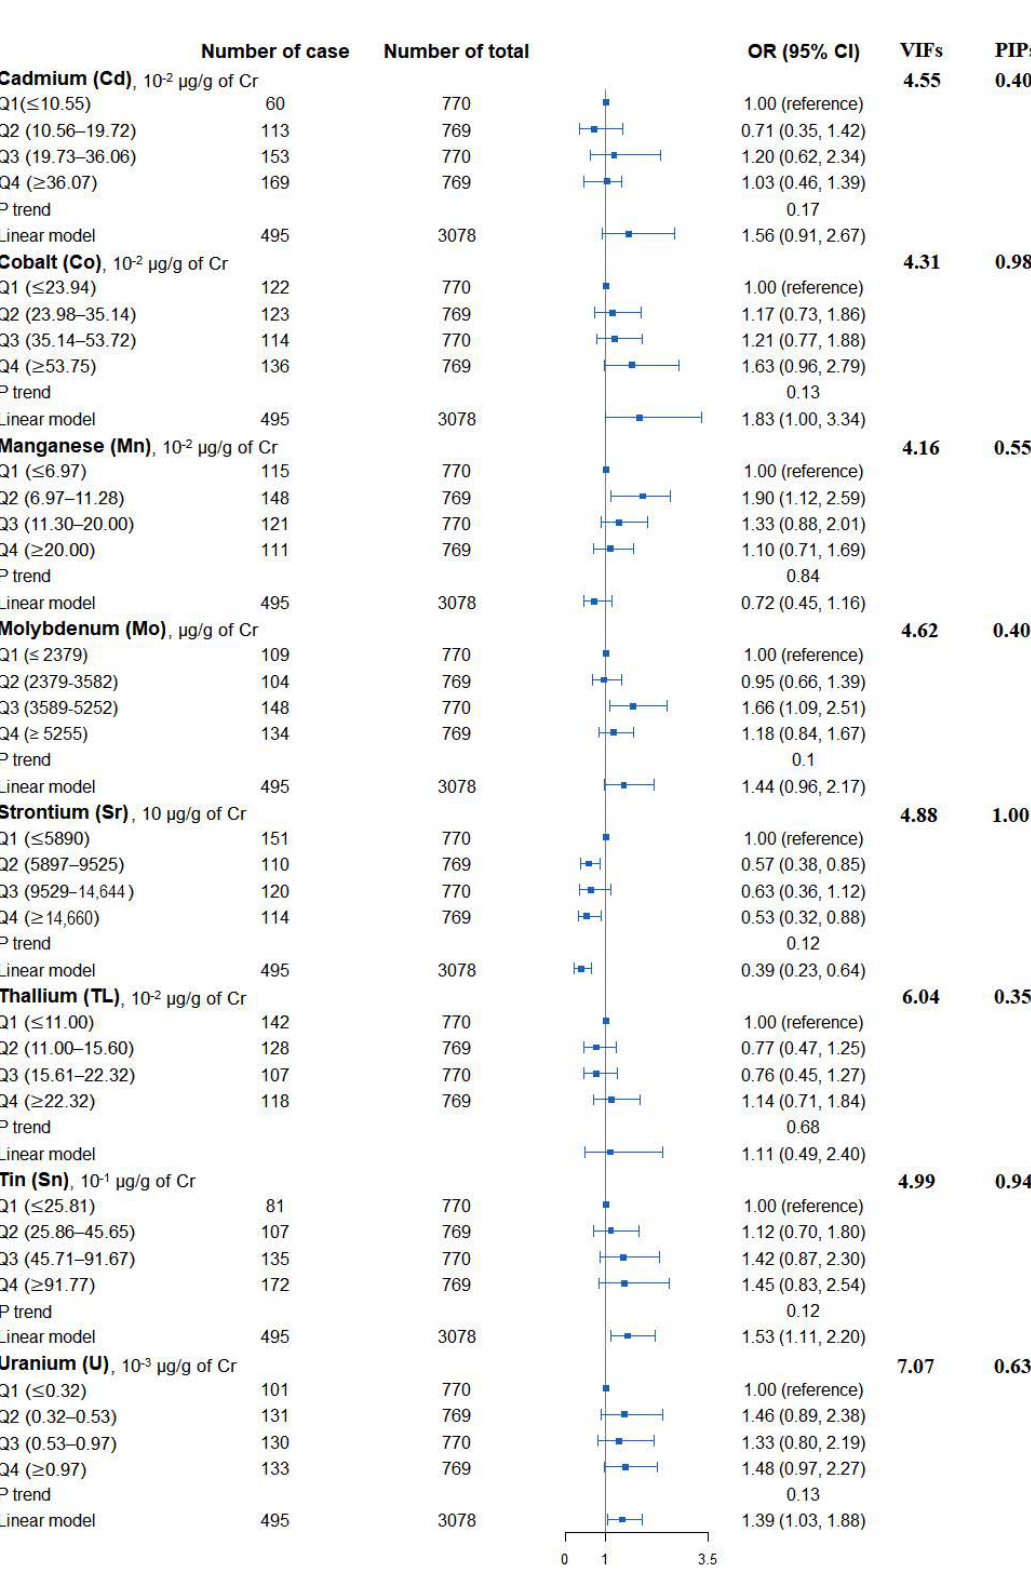
Figure 1. Associations of urinary metals with prevalence of type 2 diabetes, their collinearity in logistic regression models, and the importance in BKMR models. Model adjusted for sex, age, race/ethnicity, educational attainment, poverty-income ratio, smoking status, alcohol consumption, physical activity, body mass index, average daily energy intake, family history of diabetes, hypertension, alanine aminotransferase, gamma-glutamyl transferase, and estimated glomerular filtration